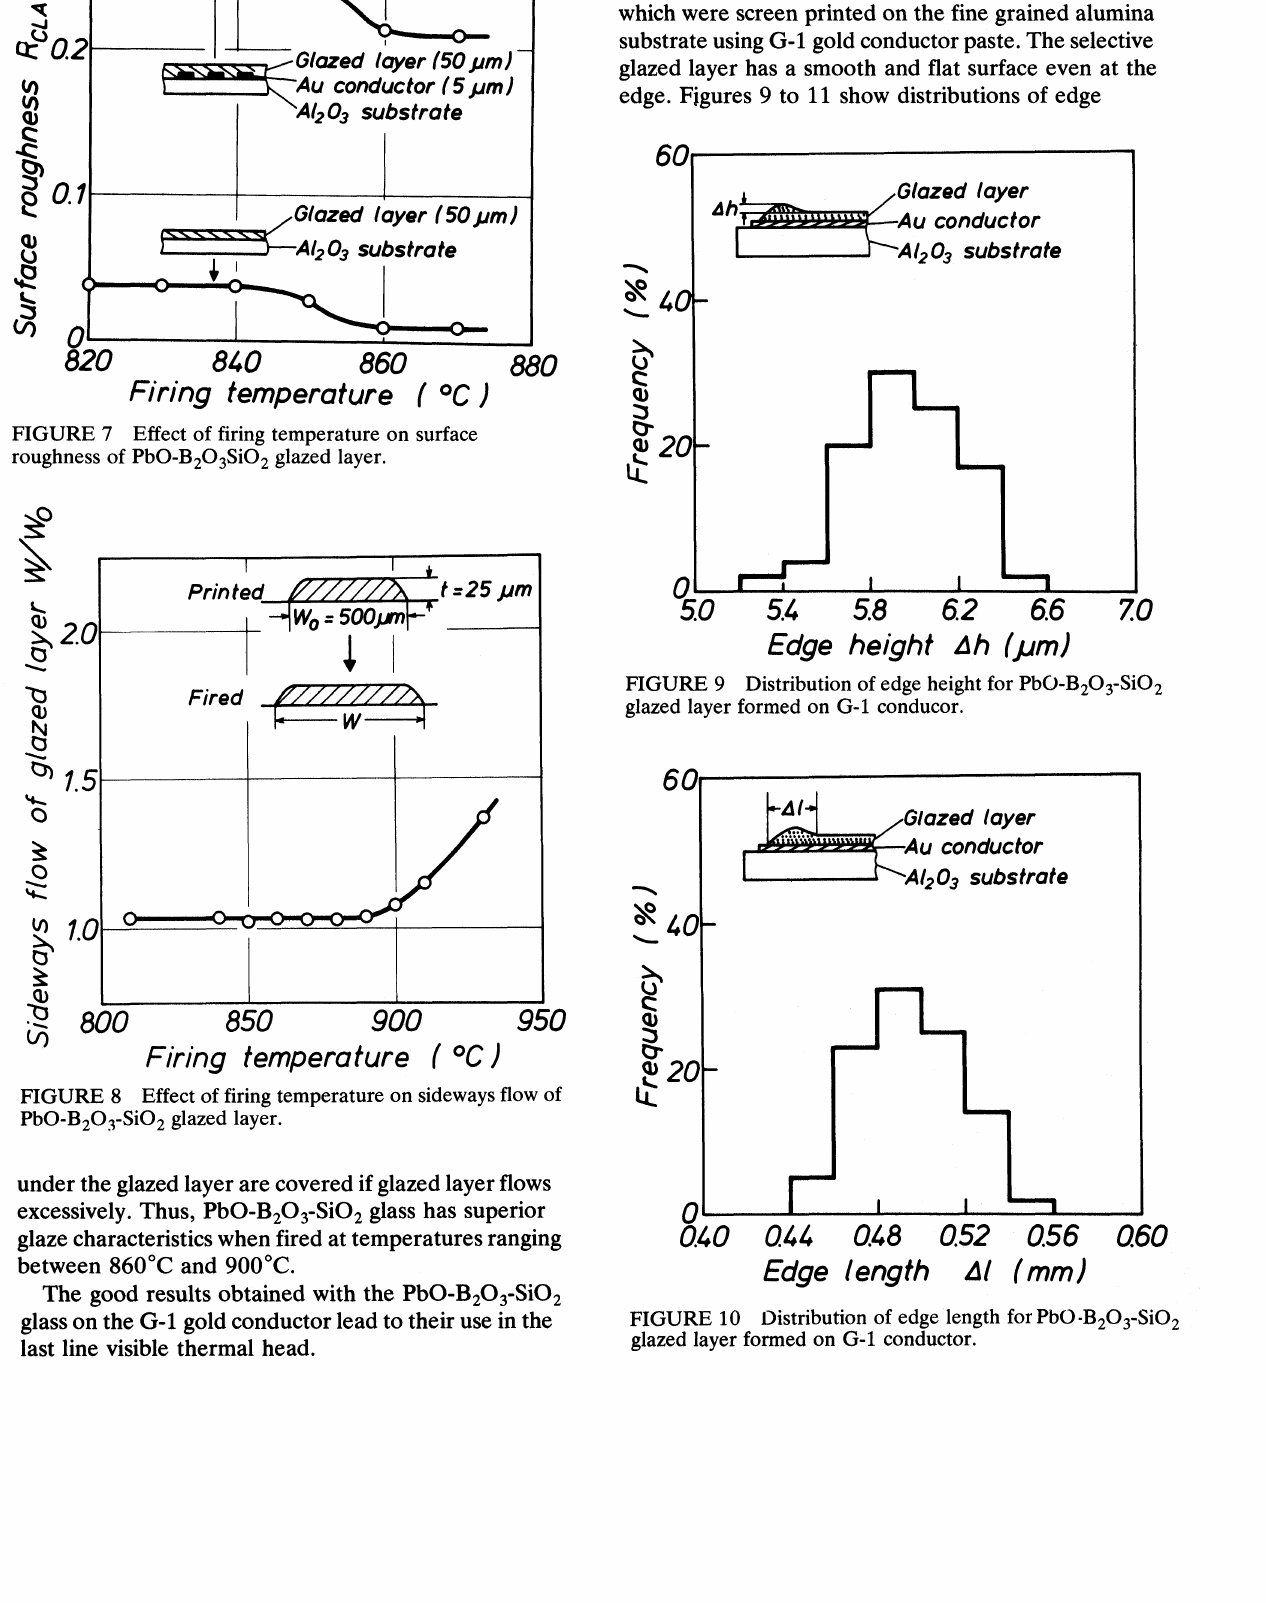
FIGURE 10 Distribution of edge length forPbO.B203-SiO glazed layer formed on G-1